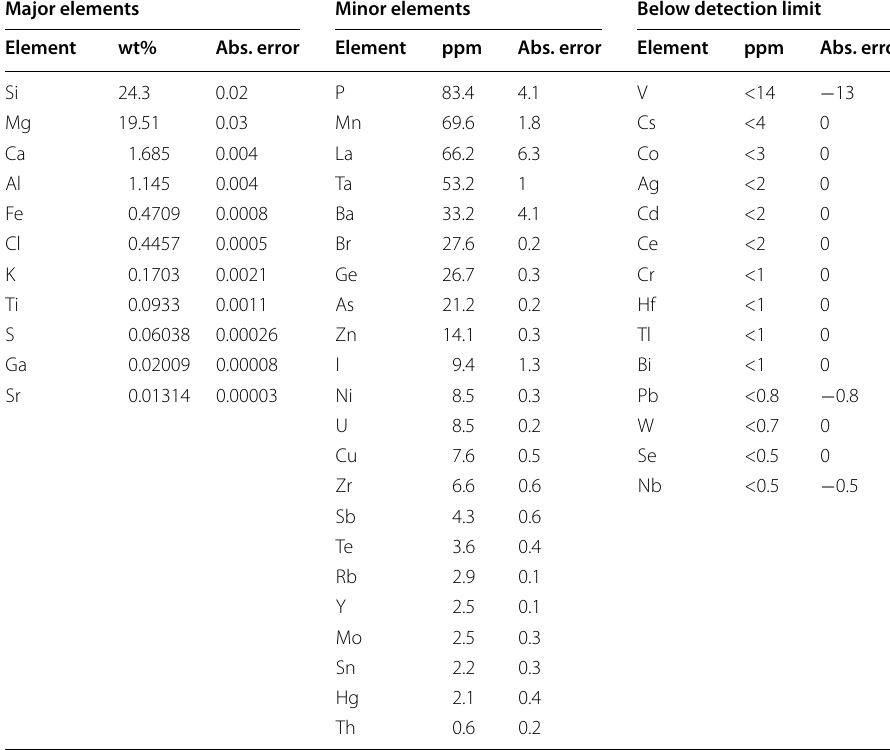
Elements below the detection limit are given as “< detection limit ”